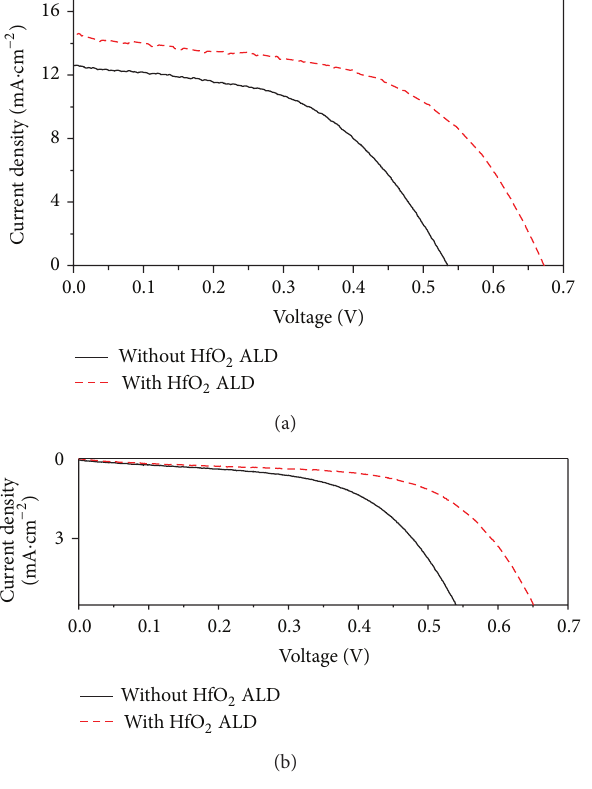
Figure4: J-V characteristics of devices beforeand aftertheinsertion of a compact HfO 2 blocking layer by ALD (a) under AM 1.5 illumination and (b) at dark